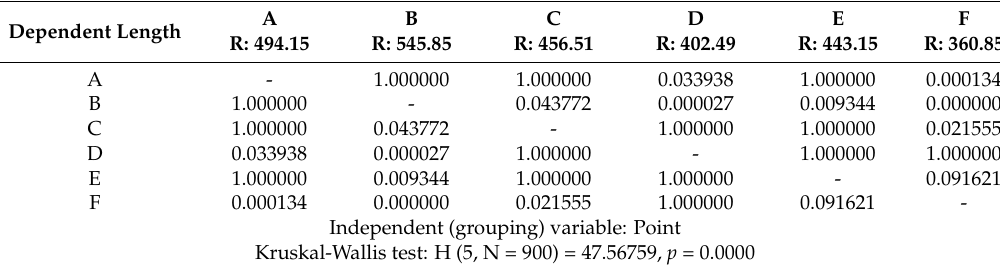
Table 9. Multiple comparisons p -values (2-tailed) of length values for point